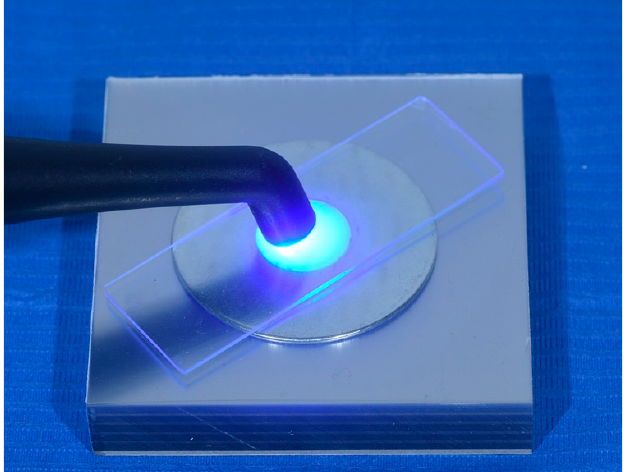
Figure 1. Example of the mold used to prepare the resin cement specimens. Light-curing was performed through the PVC sheet that was used to limit the formation of air-bubbles or structural inhomogeneities within the material.